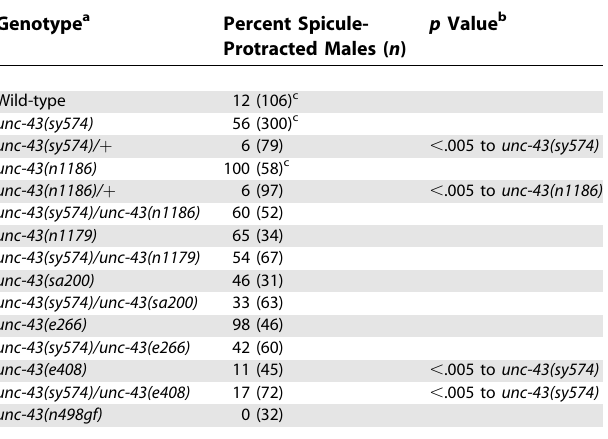
Table 2. Effect of Mutant CaMKII/ unc-43 Alleles on Male Spicule Protraction Genotype a